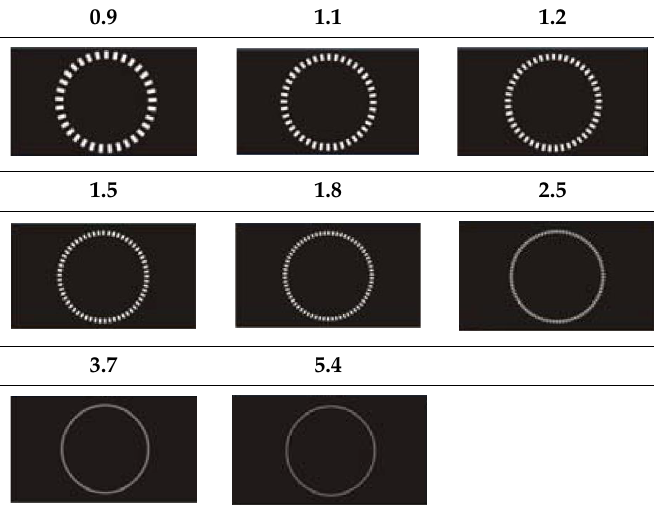
Table 4. Spatial frequency variations.